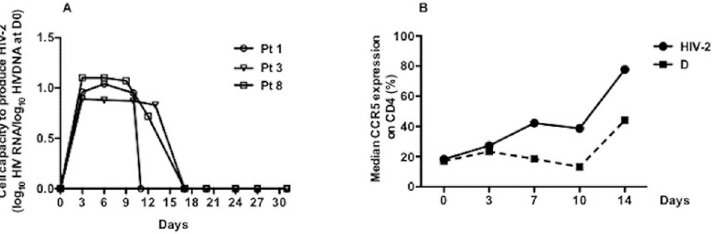
Fig 5. A) In vitro inducibility of HIV-2 reservoir in CD8-depleted peripheral blood mononuclear cells (PBMCs). Cell capacity to induce HIV-2 replication was evaluated in 11 HIV-2 infected subjects by stimulating CD8-depleted PBMC with anti-CD3/anti-CD28 co-stimulation plus IL-2, plus IL-7 plus IL-15. Allogeneic feeder CD8-depleted PBMC from a donor were added to culture at D13. Culture supernatants were collected every three days for HIV-2 viral load quantification from D0 to D31. Results are expressed as the log10 of the ratio between the numbers of HIV-RNA copies quantified on a given day of culture and the level of total HIV-DNA in the subset measured at D0 of culture. Each symbol represents a subject. B) Expression of CCR5 in culture on CD4 T-cells from 7 HIV-2 infected subjects (dot) compared to 7 donors (D) (square). Median expression of CCR5 on CD4 T-cells during 14 days of culture is represented.